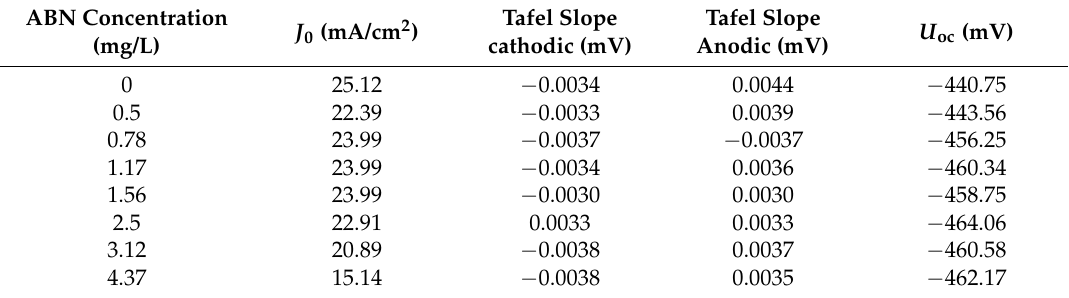
Table 3. Influence of the ABN concentration on the kinetic parameters in the MSA electrolyte.